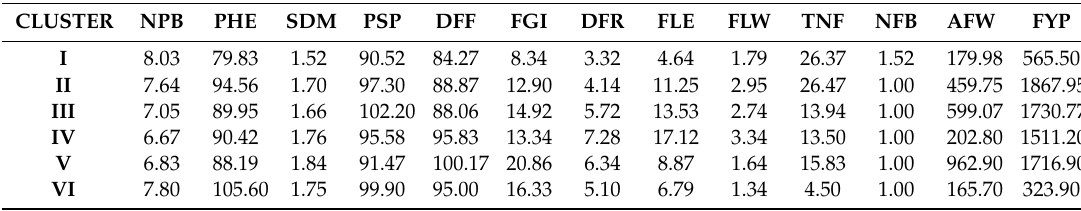
Figure 1. Dendrogram of 29 eggplant accessions based on quantitative traits generated by unweighted pair group method with arithmetic mean (UPGMA) at a 0.35 similarity coe ffi cient. Table 8. Cluster group and quantitative traits